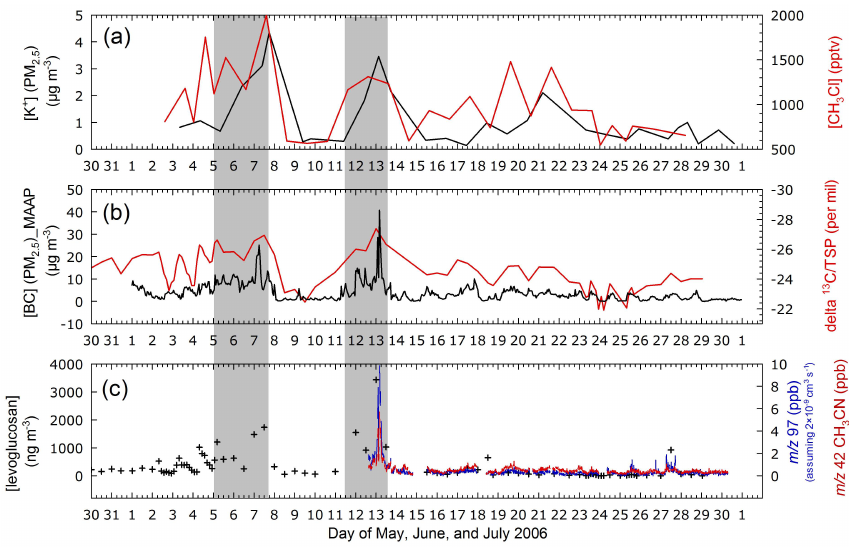
Fig. 9. Time series of selected biomass burning tracers. Hatched areas indicate two episodes with strong influences from OCRB. Panel (c) shows correlations between levoglucosan concentrations from TSP filter samples (plus marks) and m/z 97 and m/z 42 (CH 3 CN) signals (colored solid lines) derived from continuous PTR-MS